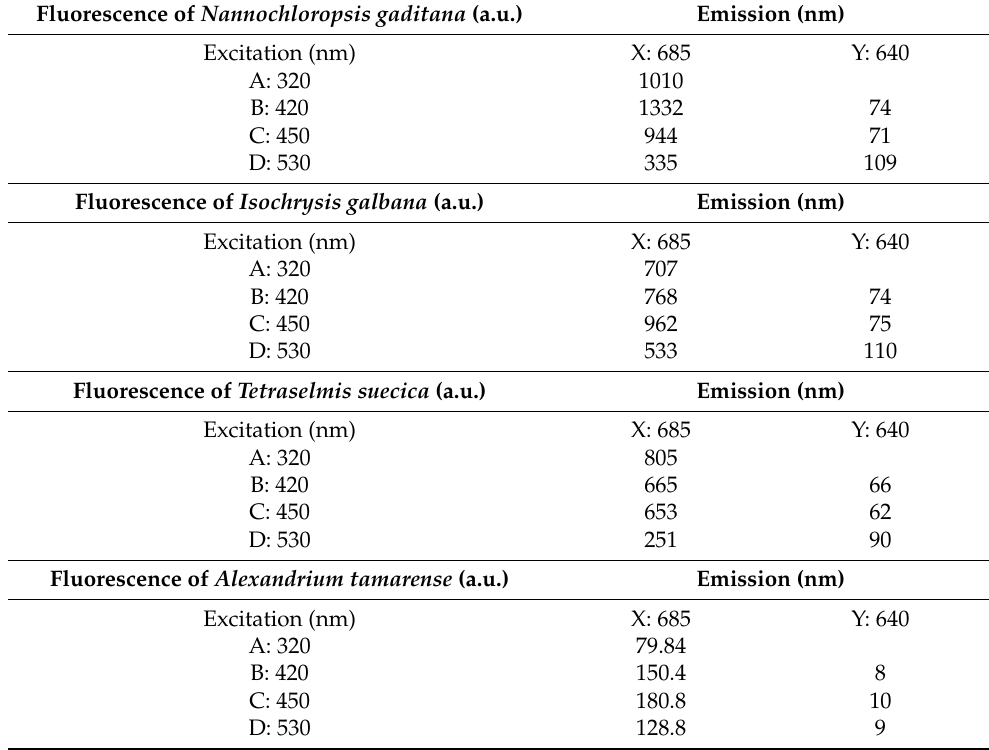
Table 5: six ratios resulting from the four fluorescence values obtained at 685 nm, with the four different excitation wavelengths (320 nm, 420 nm, 450 nm and 530 nm), named the emission obtained at 685 nm and 640 nm, for each excitation wavelengths (320 nm, 420 nm, 450 nm and 530 nm), named FBX/BY, FCX/CY and FDX/DY. These ratios are presented in Table 6 for each